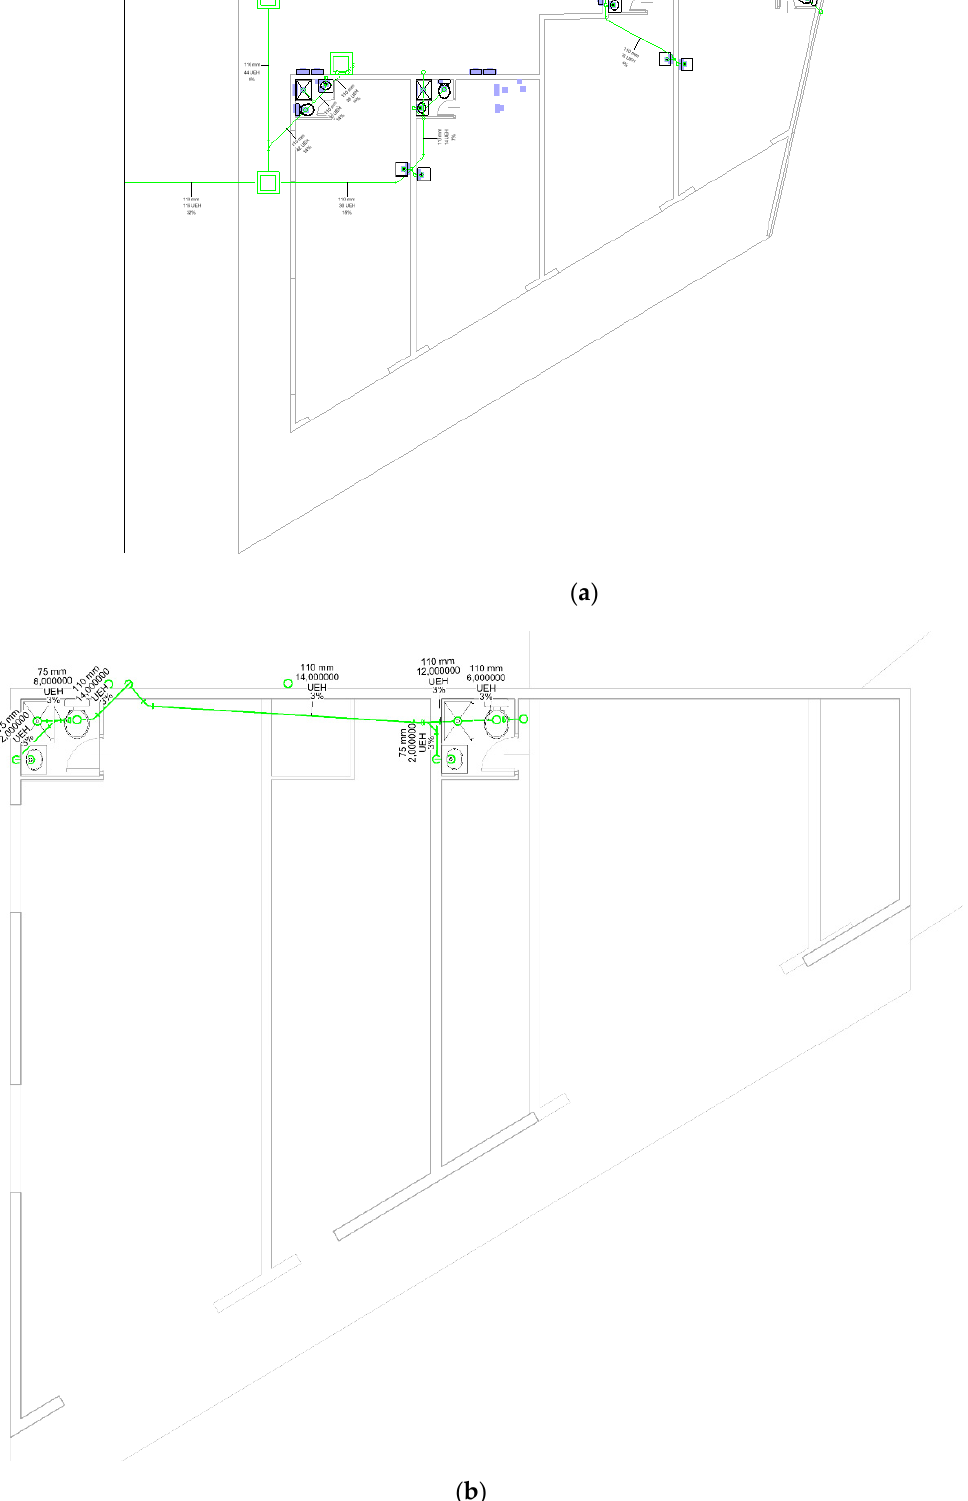
Figure 17. Sewerage system floor plan, including calculated HEUs for each segment on the first story ( a ) and the second story ( b ).